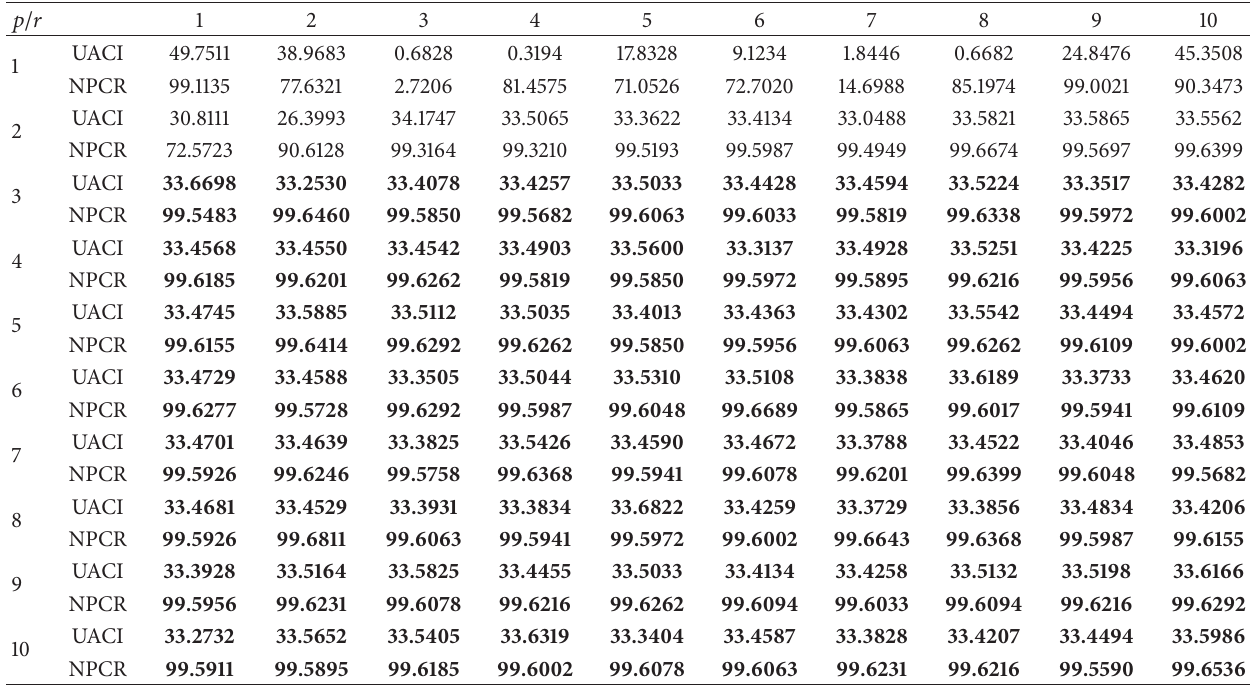
Table 14: Calculated UACI and NPCR for different combinations of 𝑝 and 𝑟 while 𝑞 = 1 for Chess-plate.